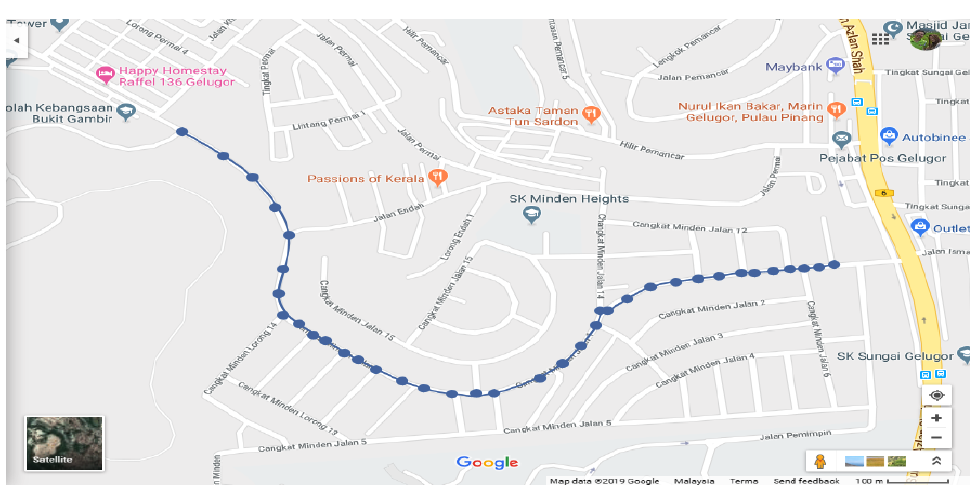
Figure 9. Minden Route Curve Constructed with Hermite Interpolation Curve. A total of 102 coordinate points were obtained in longitude and latitude forms from Garmin BaseCamp along the desired routes. The obtained coordinates were then fitted into the algorithm to calculate the curvature value and the travel-time estimation. From the 102 coordinates that was picked from the BaseCamp, a total of 51 curves was produced for this paper. Afterwards, by referring to Section 3.4.1, the longitude and latitude coordinates are then converted into decimal degrees and meters. Finally, by referring to Section 3.4.2, to calculate the value of curvature, the curvature value for each 51 curve is obtained (see Table A1). Using the built-in function ListLinePlot in Mathematica, the curvature value graph for each curve can then be plotted as shown in Figure 10.